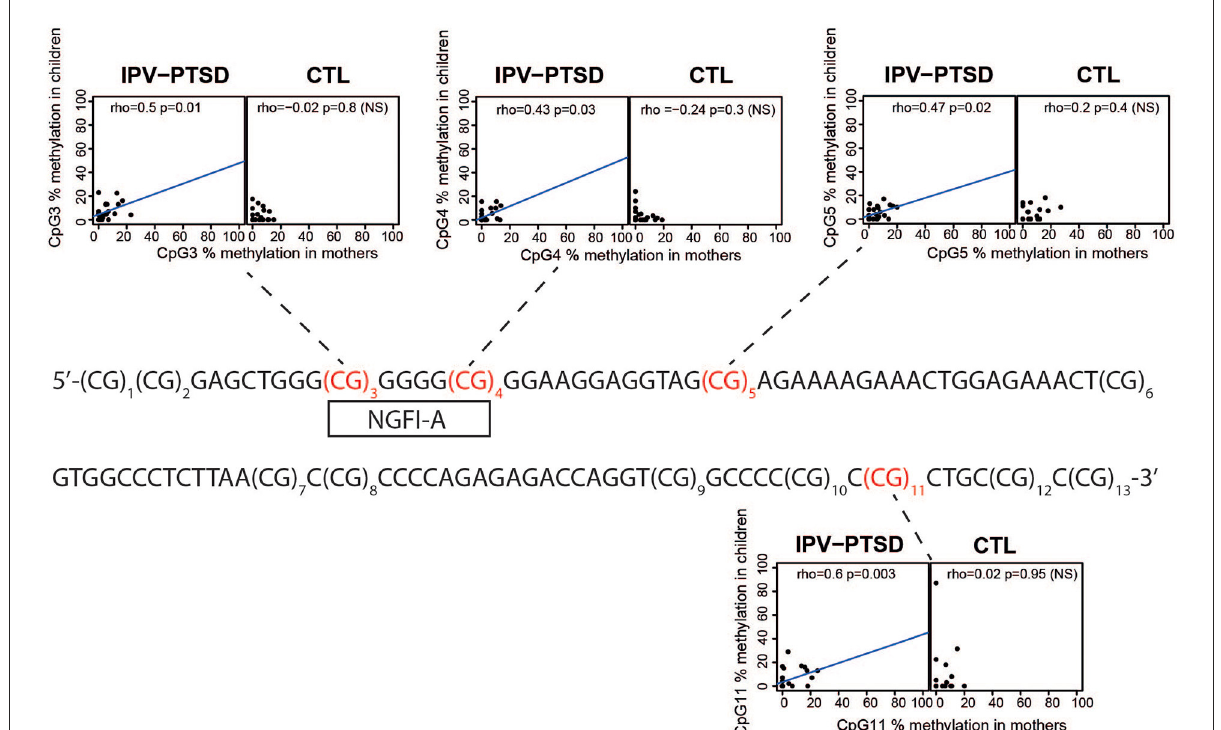
FIGURE2 The original sequence of the bisulfite-converted and pyro-sequenced region with the 13 successive numerated CpG sites and scatter plots of CpG methylation in CpGs where there were previous findings linking methylation and IPV-PTSD. These scatter plots show CpG methylation in mothers and children separated by interpersonal violence related post-traumatic stress disorder (IPV-PTSD) or non-PTSD (CTL) among